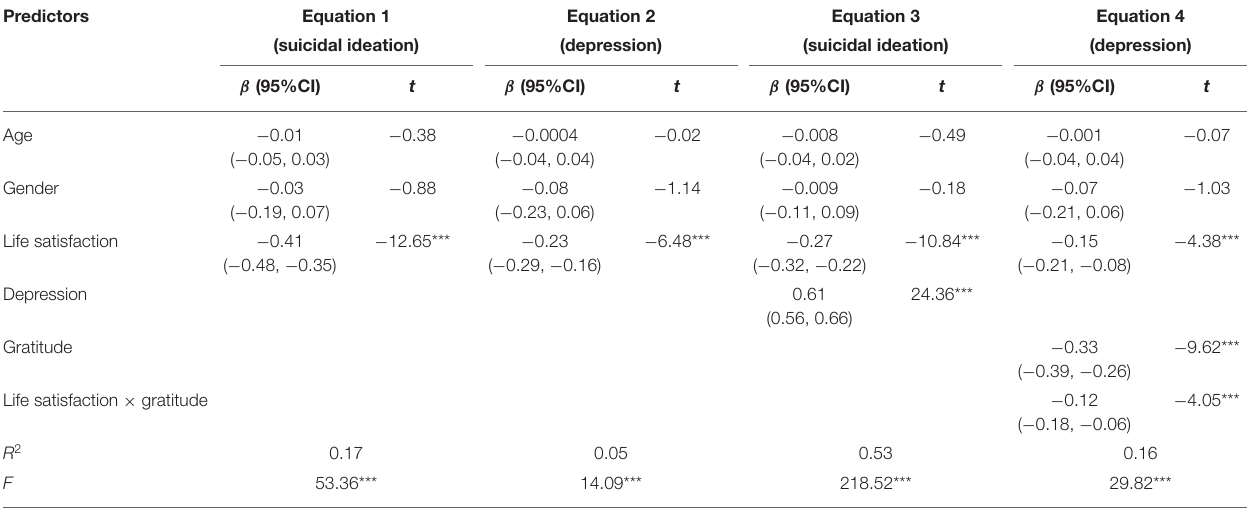
TABLE 2 | Testing the mediation effect of life satisfaction on suicidal ideation.